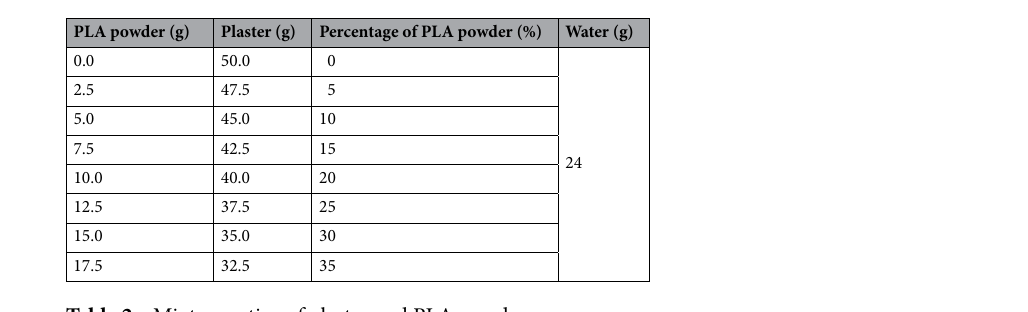
Table 2. Mixture ratios of plaster and PLA